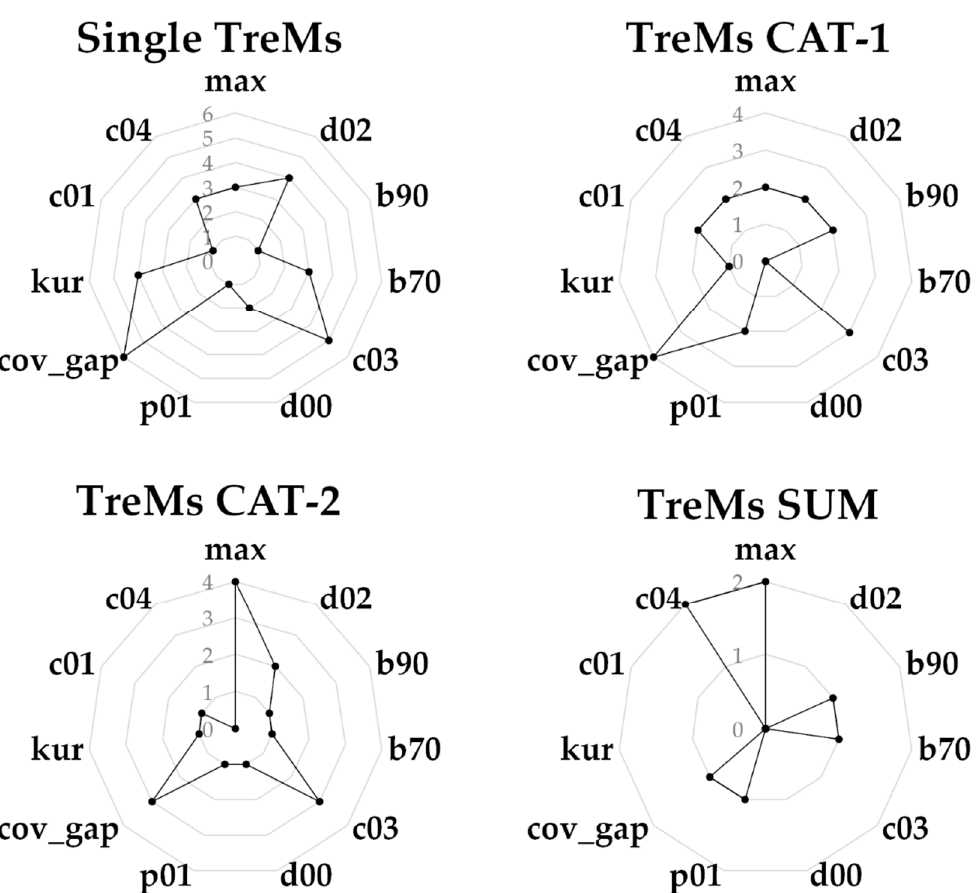
Figure 3. Spider plots depicting the ALS metrics’ recurrence. The dots indicate the number of times that the 11 ALS metrics were selected for microhabitat prediction among hierarchical classification levels.